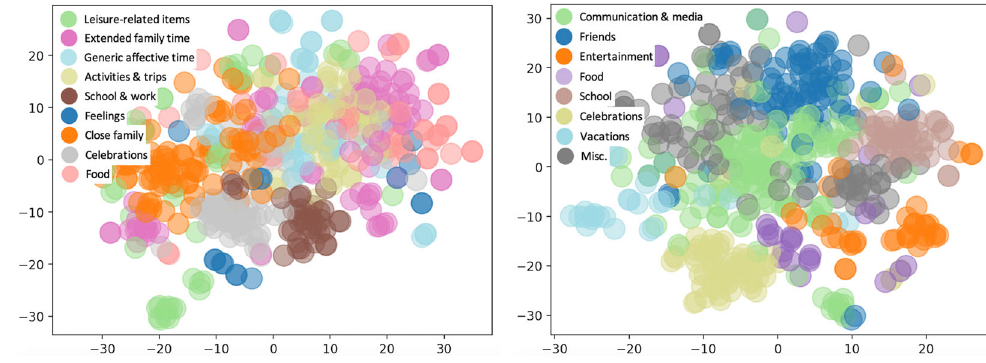
Fig. 6 Clusters for affection (left) and bonding (right). In spite of their apparent similarity, their keywords refer to different types of happy moments according to the people we are surrounded by (family in the case of the former, and friends for